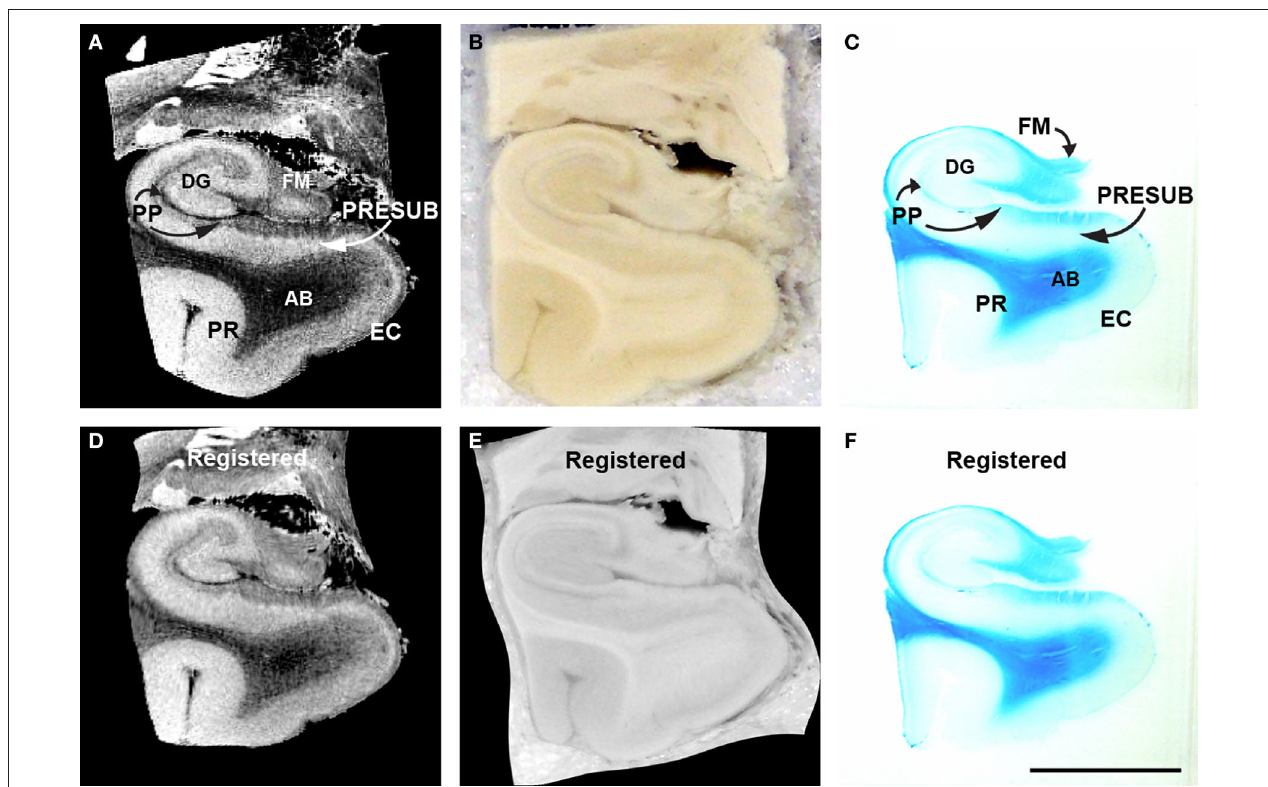
Figure 10 | Mri (A), blockface (B), myelin stained (C) medial temporal lobe of corresponding sections and accompanying registered Mri (D) blockface (e) myelin stained (F). Perforant pathway is stained with Luxol fast blue, a